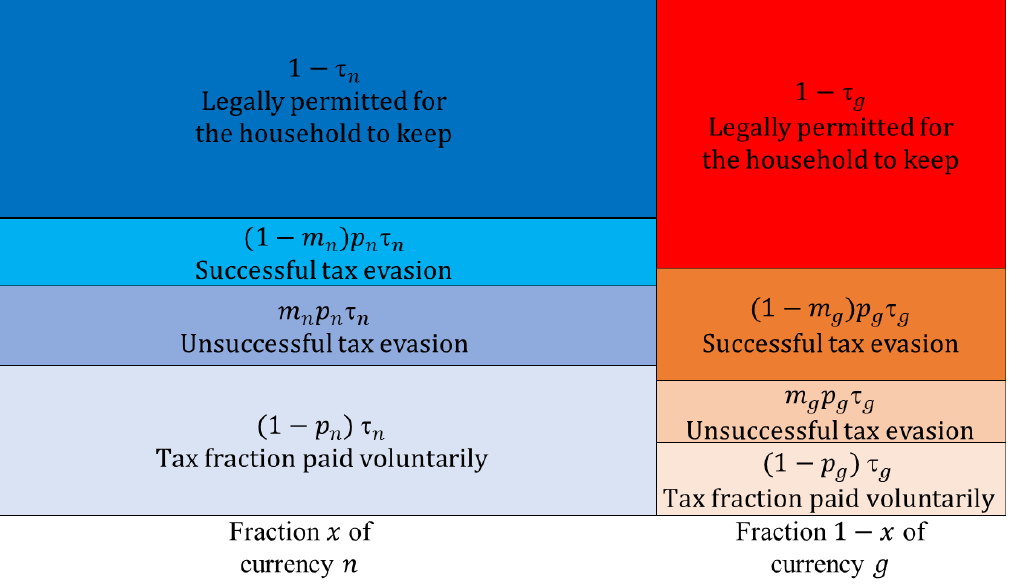
Figure 3. Fractions 𝑥 and 1 − 𝑥 of the household’s currencies 𝑛 and 𝑔 , each divided into four subgroup fractions, i.e., 1 − 𝜏 (cid:3037) as legally permitted for the household to keep, (cid:3435)1 − 𝑚 (cid:3037) (cid:3439)𝑝 (cid:3037) 𝜏 (cid:3037) as successful tax evasion, 𝑚 (cid:3037) 𝑝 (cid:3037) 𝜏 (cid:3037) as unsuccessful tax evasion, and (cid:3435)1 − 𝑝 (cid:3037) (cid:3439)𝜏 (cid:3037) as the tax fraction paid voluntarily, 𝑗 = 𝑛,𝑔 .